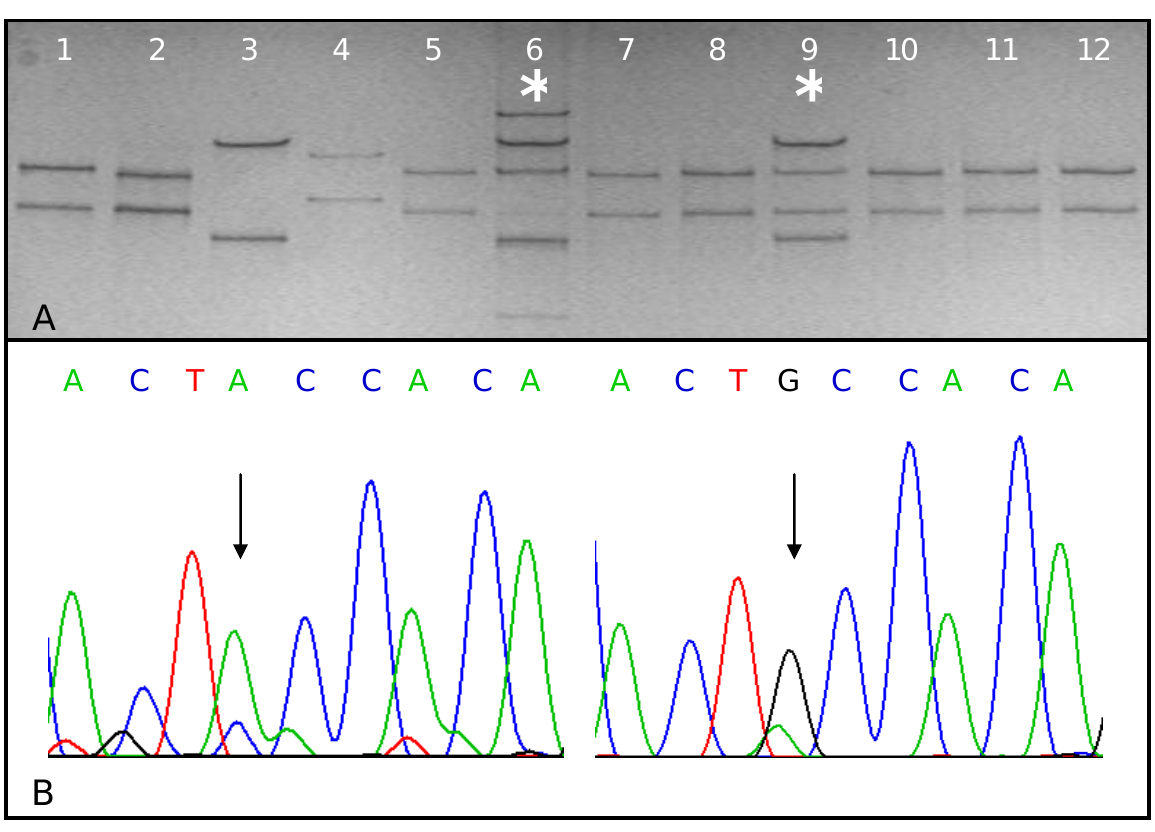
Figure 1. (A) PCR-SSCP analysis of the CTNNB1 gene. Lane 1: wild-type control; Lane 2: mutation control - codon 33 TCT→TAT; Lane 3: mutation control - codon 41 ACC→GCC; Lane 4: mutation control - codon 45 TCT→CCT, Lanes 5–12: human tissue samples No. 69, 48, 37, 41, 68, 16, 44, and 14. Lanes 6 (sample No. 48) and 9 (sample No. 68) exhibit aberrant band motilities (*). (B) Sequencing profiles of DNA fragments isolated from SSCP gel. On the left side: wild-type sequence at codon 41. On the right side: shifted band sequence of sample No. 48. Arrows show the transition of wild-type adenine (on the left side) to guanine (on the right side) at the first base position of codon